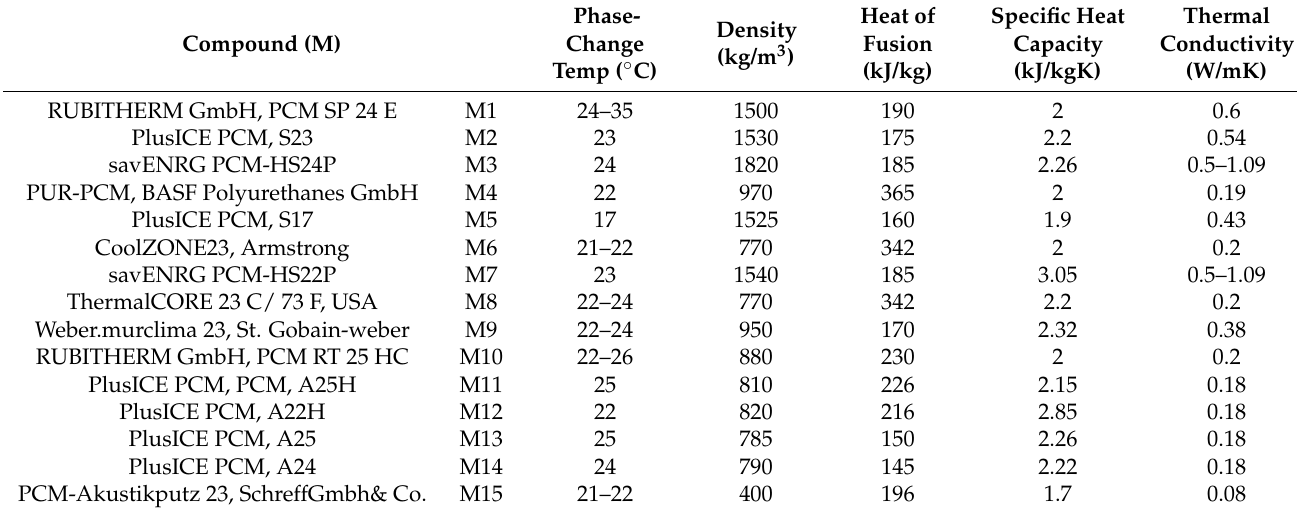
Table 1. List of phase-change materials and their thermo-physical properties.